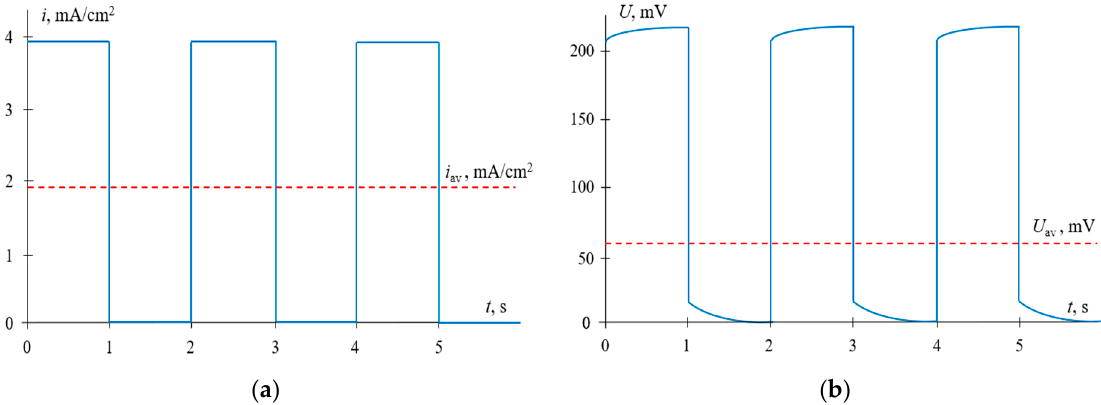
Figure 4. Time dependences of the current density ( a ) and voltage ( b ) for the pulsed electric field (PEF) mode, when current pulses are applied. i av is the time–average current density; U av is the average voltage. The results of calculations at α = 0.5, f = 0.5 Hz and i CC = i pulse = 0.6 i lim .